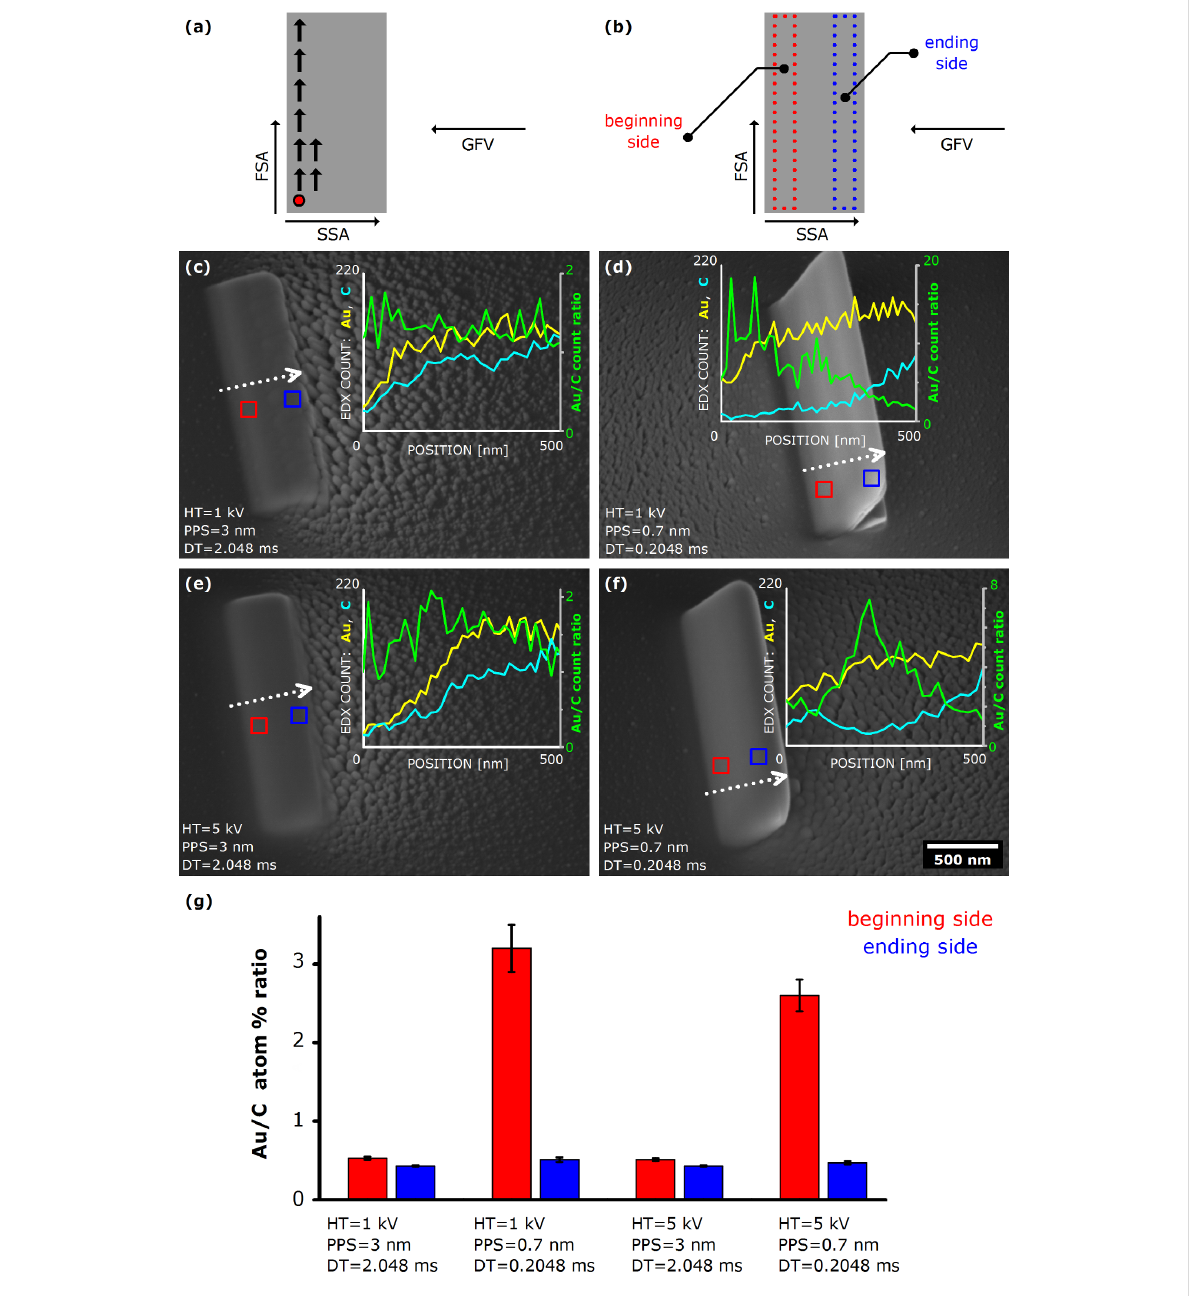
Figure 3: (a) Schematics of the scanning strategy used in FEBID of planar structures. (b) Definition of “beginning” and “end” of the structures, with respect to the scanning strategy. Note that both areas are ≈ 50 nm away from the respective edges of the planar structure. (c–f) SEM images (tilted view) of planar Au structures measuring 2 × 0.5 μ m 2 in area, deposited using various experimental conditions. Plots containing EDX line profiles are given in the insets. Note the change of scale for Au/C count ratio among the images. The scale bar indicated in (f) applies to all SEM images in this figure. (g) Elemental composition of the planar structure presented in (c–f), as determined by EDX measurements performed on 100 × 100 nm 2 areas for 60 s, on the “beginning” and “end” of the deposition, marked with a red and blue square, respectively. Note a pronounced Au content on the “beginning” side in the samples produced using a higher electron beam dose. For detailed EDX data see Table S2 in Supporting Information File 1.